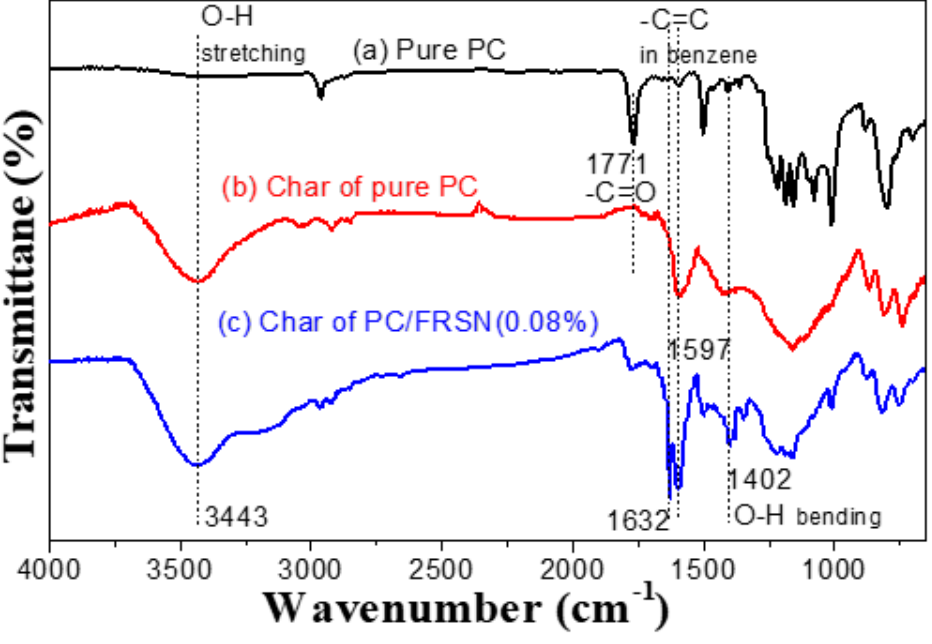
Figure 5. FTIR spectra of ( a ) pure PC, ( b ) residue char of pure PC and ( c ) residue char of PC/FRSN (0.08 wt%) ( c ).